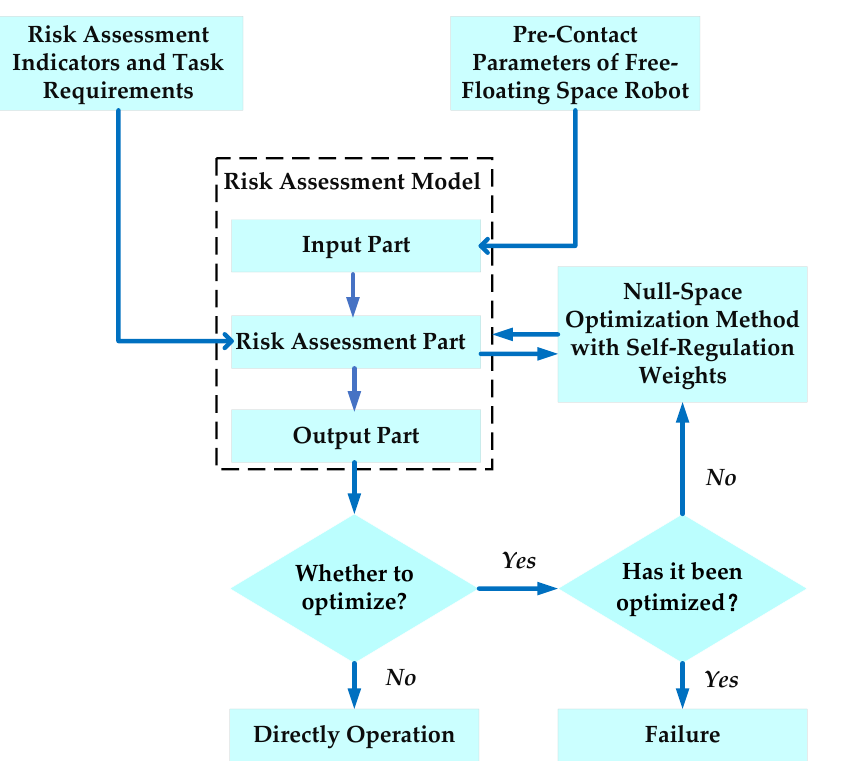
Figure 8. Flow chart of risk assessment model-guided configuration optimization method.